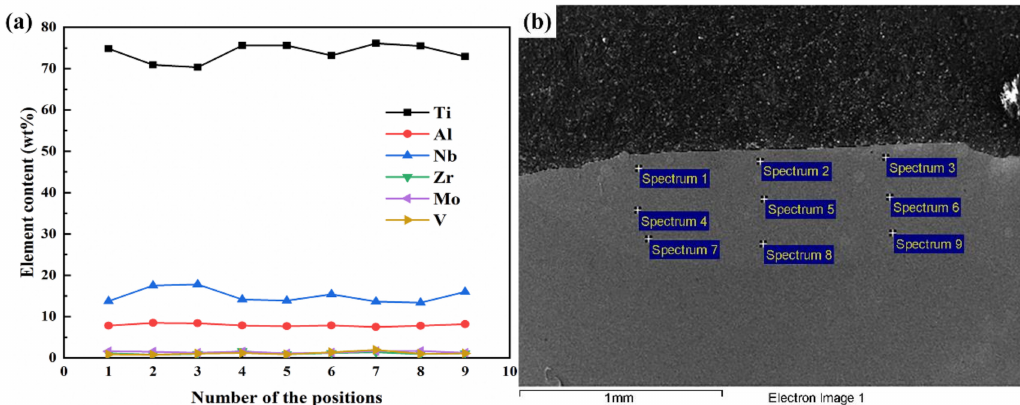
Figure 5. Chemical compositions of the single-layer sample in E1: ( a ) element content of each position in the deposited layer; ( b ) energy-dispersive spectroscopy (EDS) testing positions in single layer